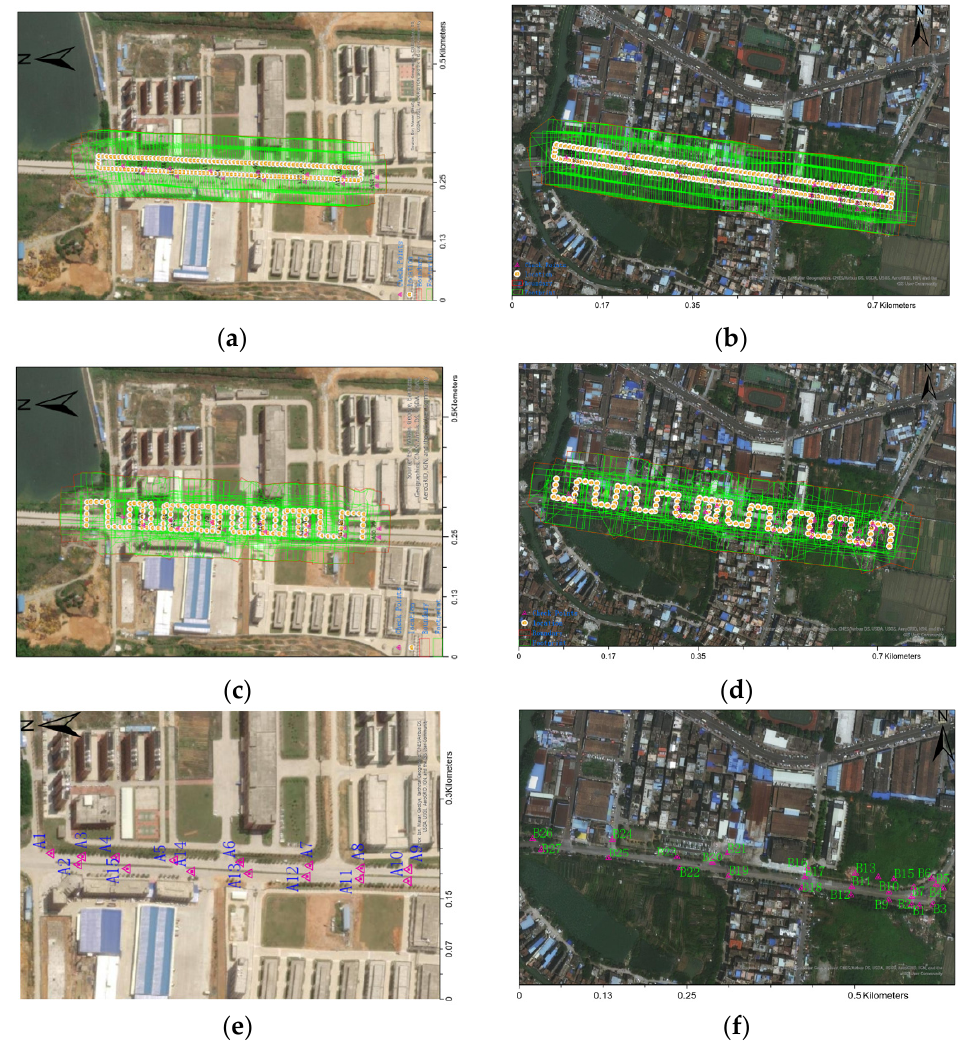
Figure 6. UAV images of the test sites. ( a , c ) The rectangle and S-shaped datasets of test site 1, respectively; ( b , d ) the rectangle and S-shaped datasets of test site 2, respectively. ( e , f ) the location distribution of GCPs in test site 1 and test site 2.